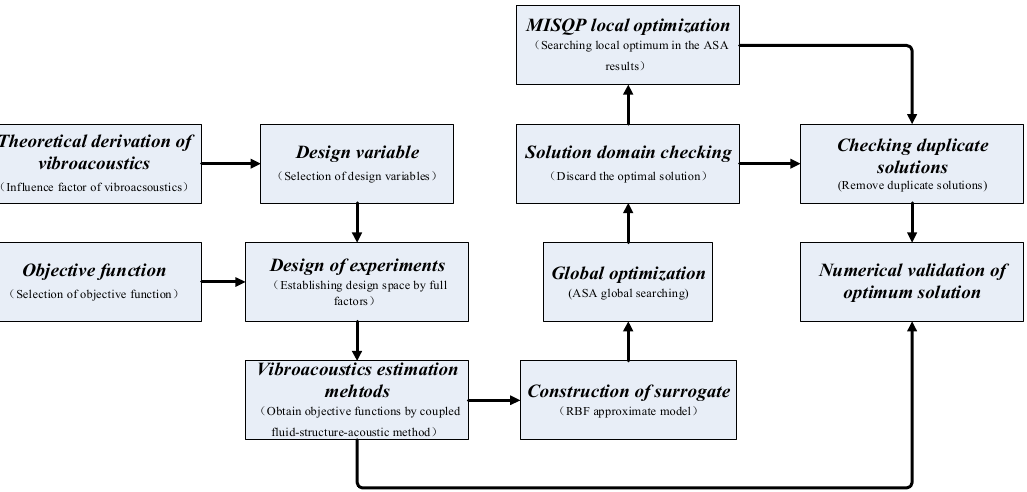
Figure 22. The flow chart of the single-objective optimization.